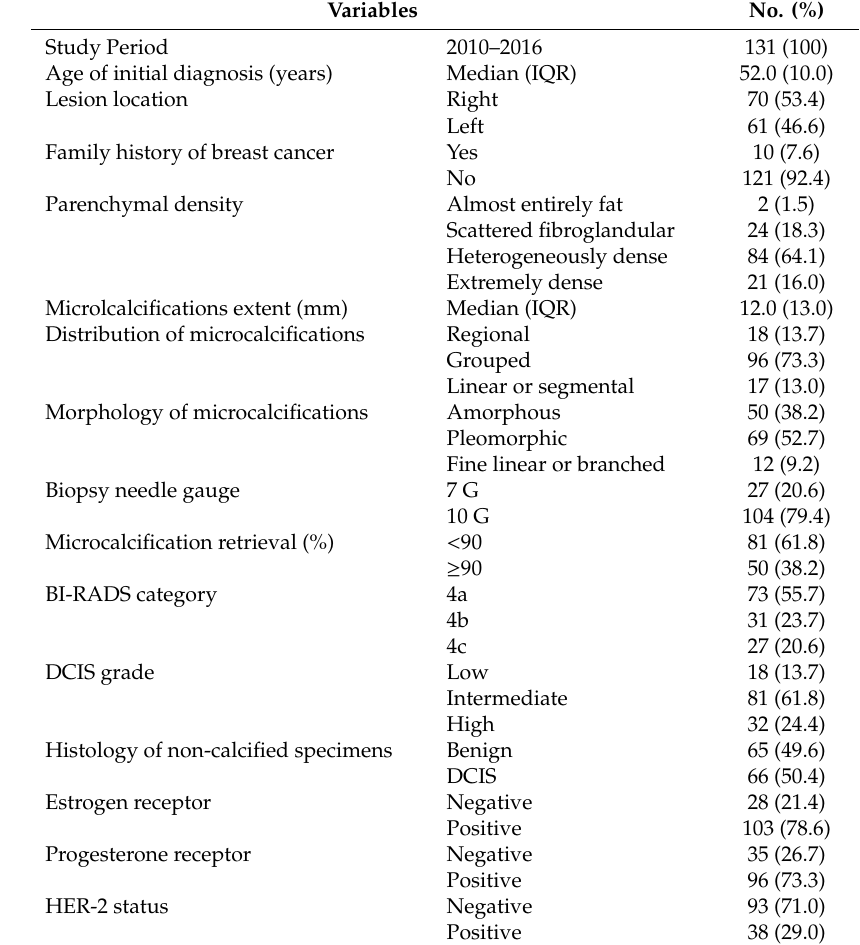
Table 1. Variables of clinical characters, mammographic features, procedural relationships and specimen